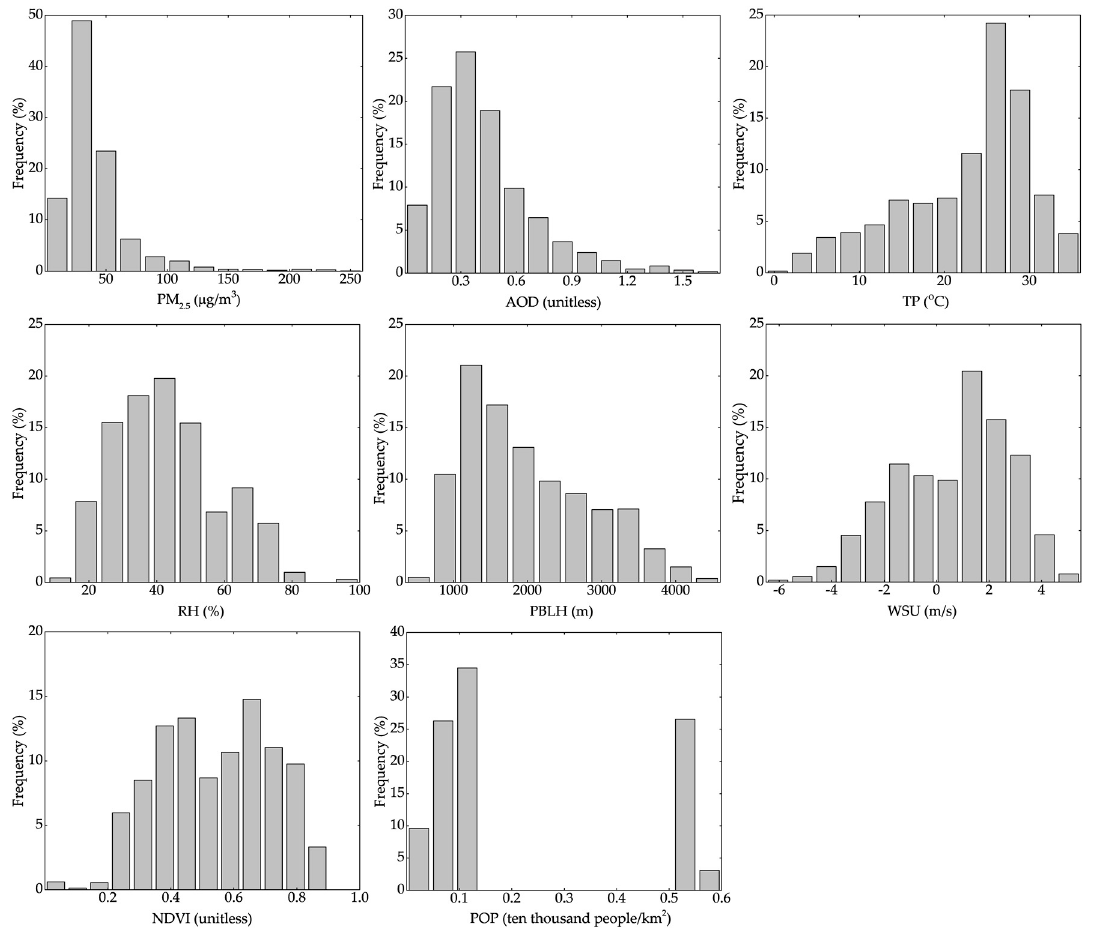
Figure 3. Histograms of dependent and independent variables in the model fitting dataset.